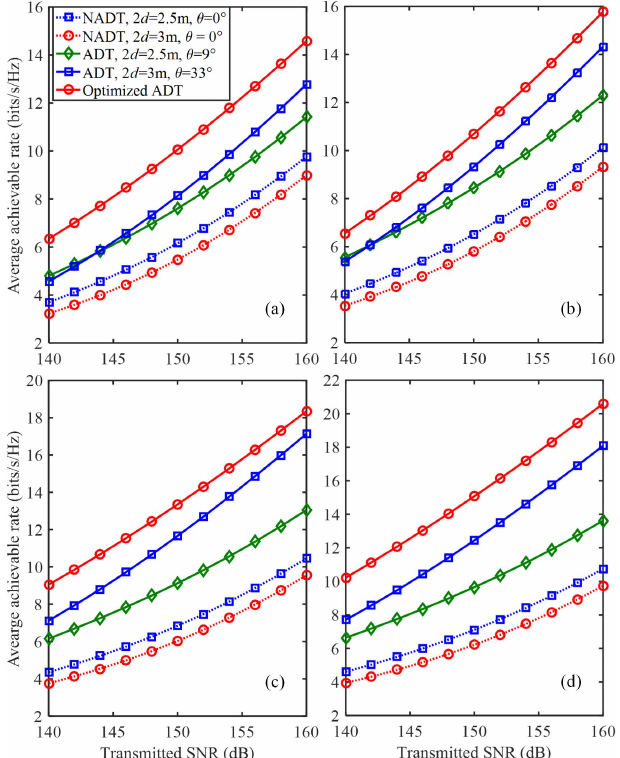
Figure 7. Average achievable rate vs. the transmit SNR in the generalized ADT with different N values for ( a ) N = 4, ( b ) N = 5, ( c ) N = 6 and ( d ) N = 7.